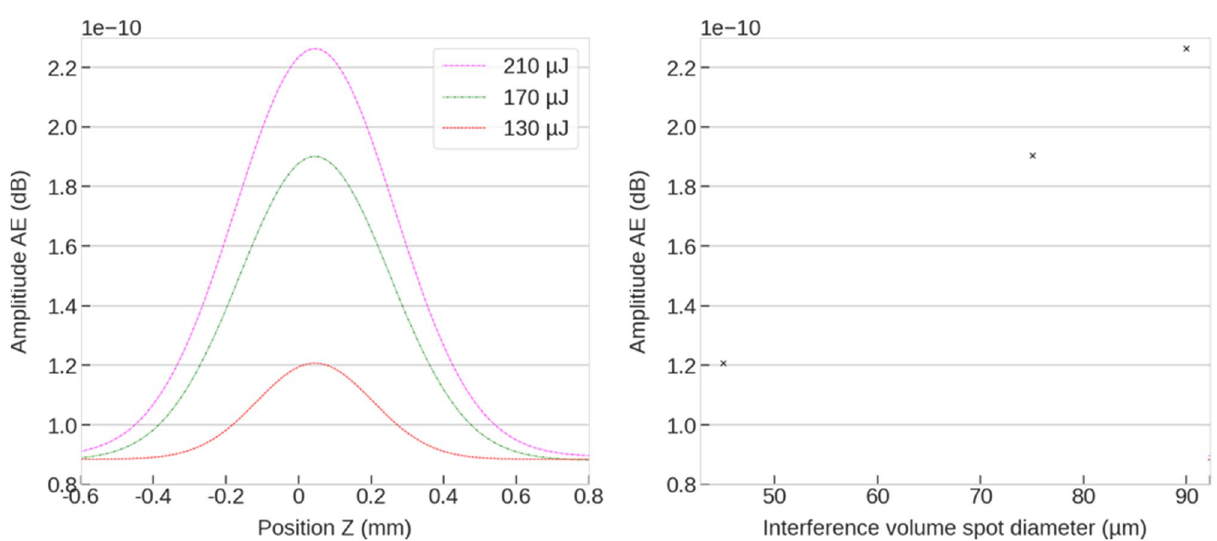
Figure 4. ( a ) Absolute maximum sound pressure level during DLIP processing for varying laser energy and z positions for spatial period of 8 µm. ( b ) Resulting interference spot diameter for pulse energies of 130, 170 and 210